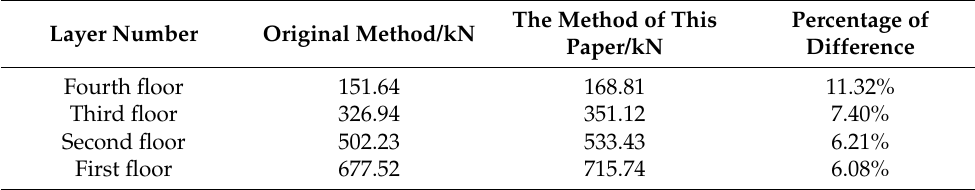
Table 3. Calculation results of pullout force of anchor-plate in example